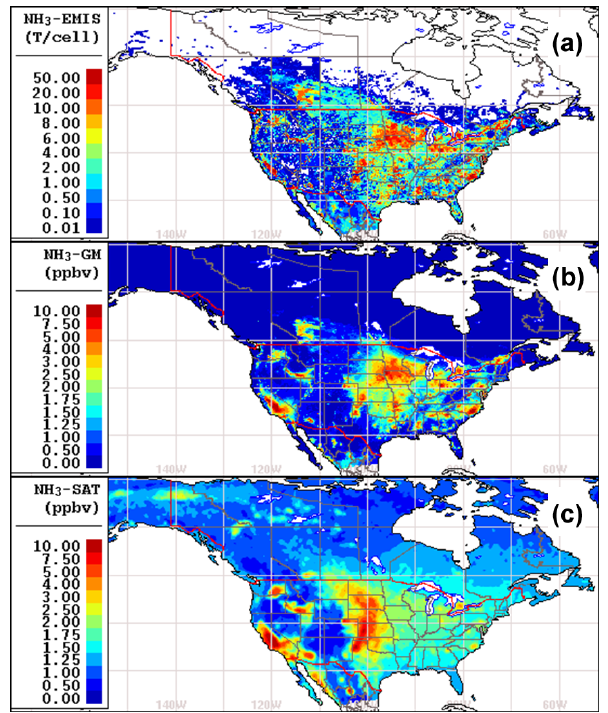
Figure 12. Mean North American agriculture ammonia (a) emis- sions used by GEM-MACH, (b) mean surface NH 3 concentra- tion field for July and August 2016 modelled by GEM-MACH, and (c) corresponding CrIS NH 3 surface concentration